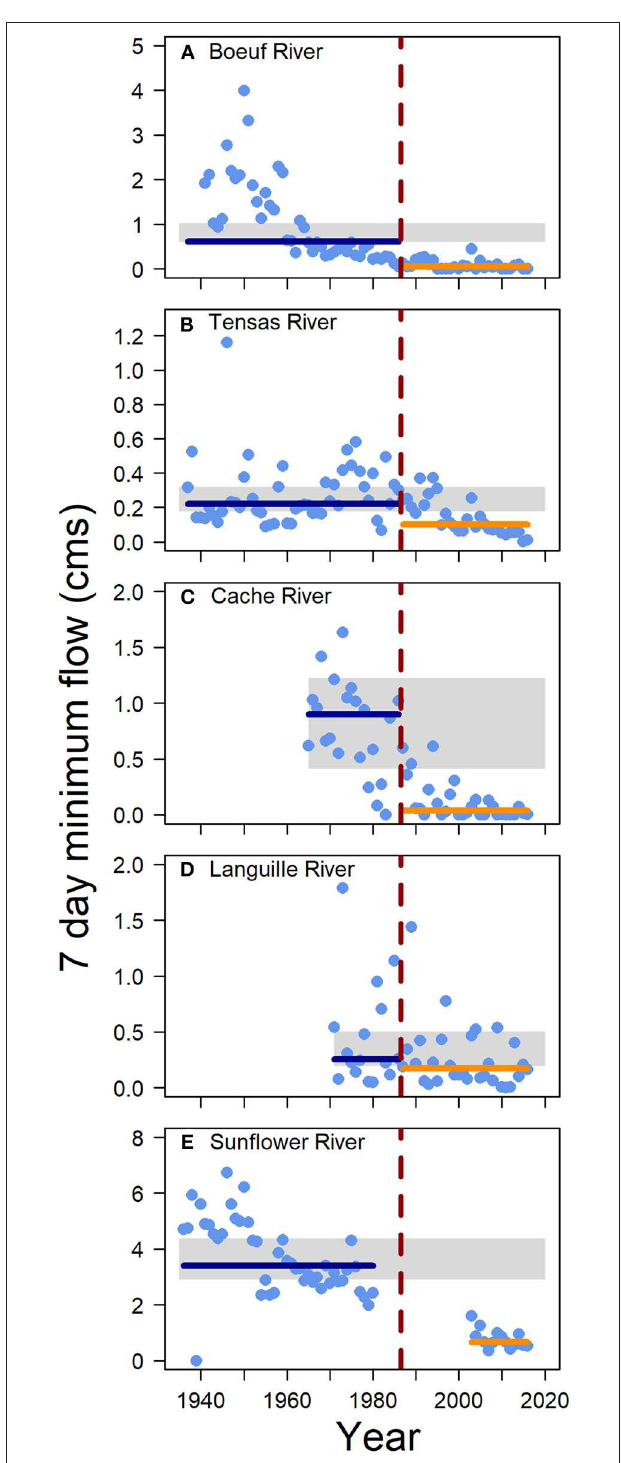
FIGURE 5 | Seven day minimum flow for all available years of data for (A) Boeuf River near Girard, (B) Tensas River near Tendal, (C) Cache River near Egypt, (D) Languille River at Colt, and (E) the Sunflower River at Sunflower gages; dark blue line is the median of values pre-1987 and the orange line is the median of values after and including 1987, gray bar represents the range of natural variability in the data